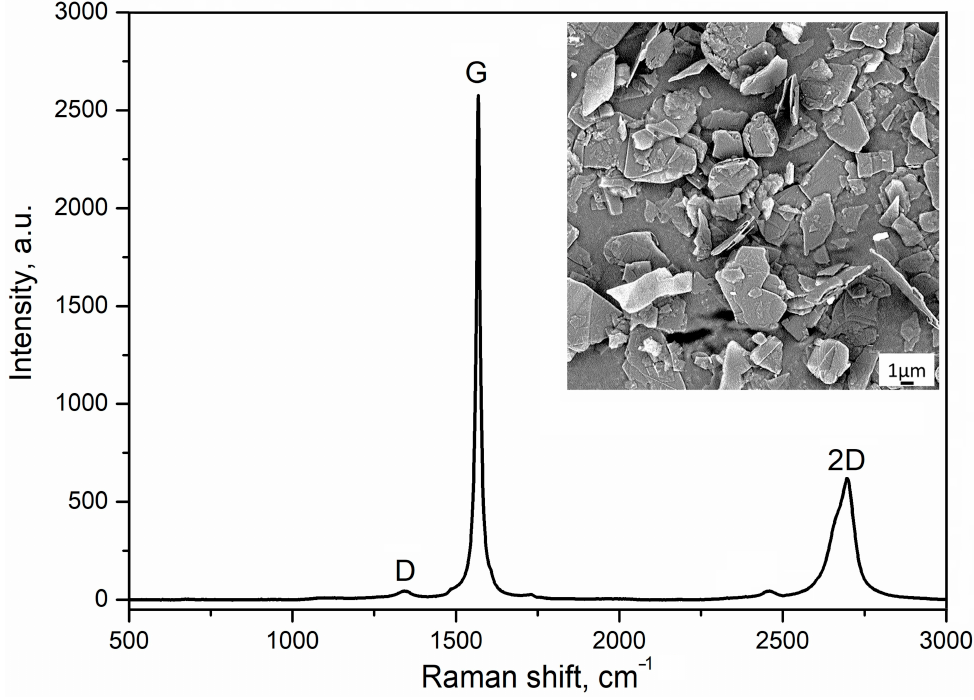
Figure 1. Raman spectrum and SEM image of raw graphite powder. A modified Hummers method was used to obtain graphene oxide from graphite powder (Figure